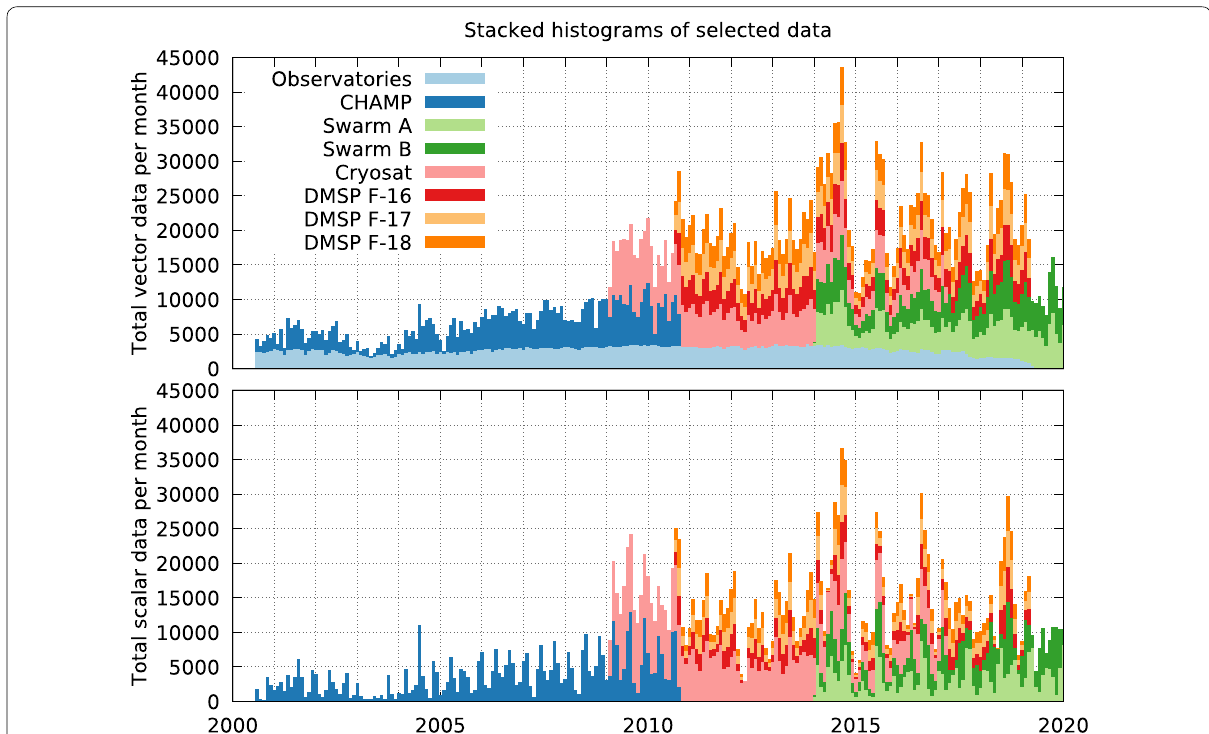
Fig. 3 Top: total number of satellite and ground observatory vector measurements (stacked histogram) as a function of time after data selection. Bottom: total number of satellite scalar measurements (stacked histogram) as a function of time after data